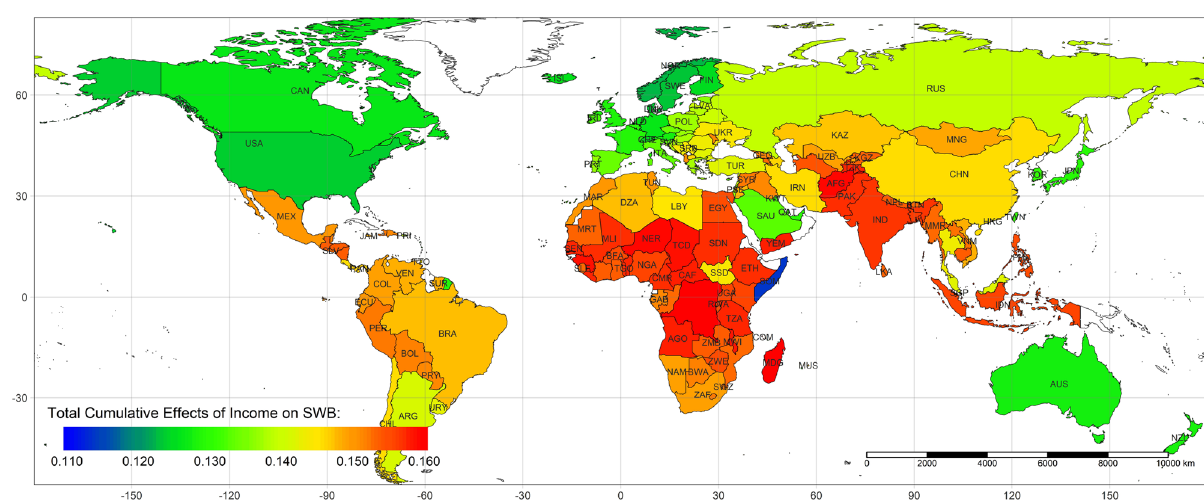
Figure 10. Map of country-level average total cumulative effects of income on